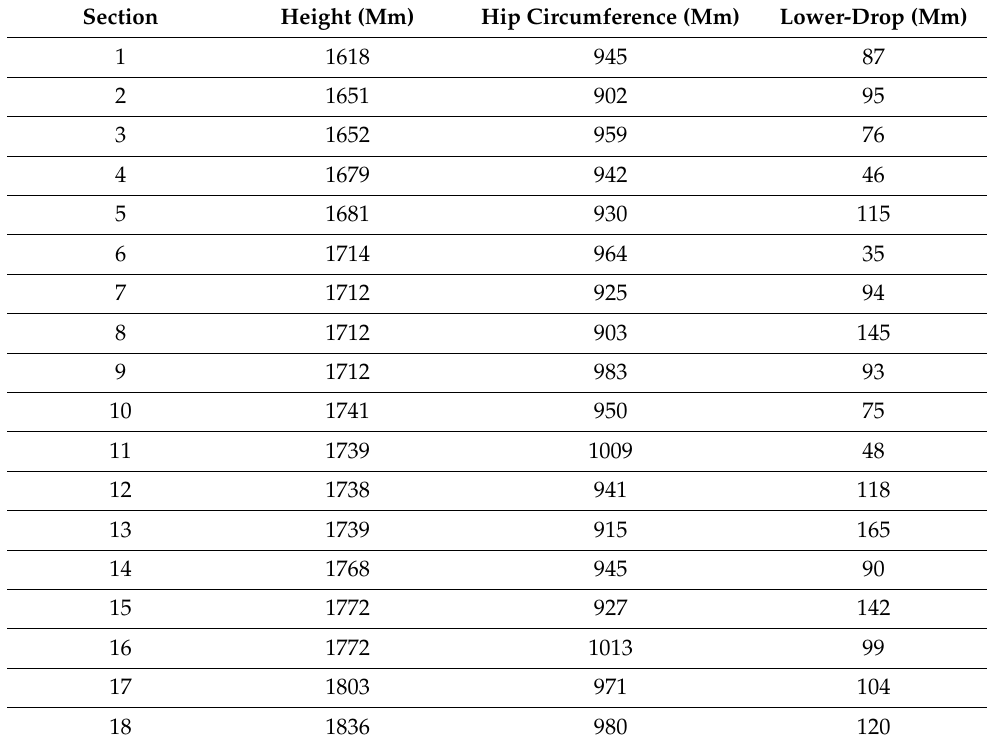
Table 9. Dimensions of important variables by representative